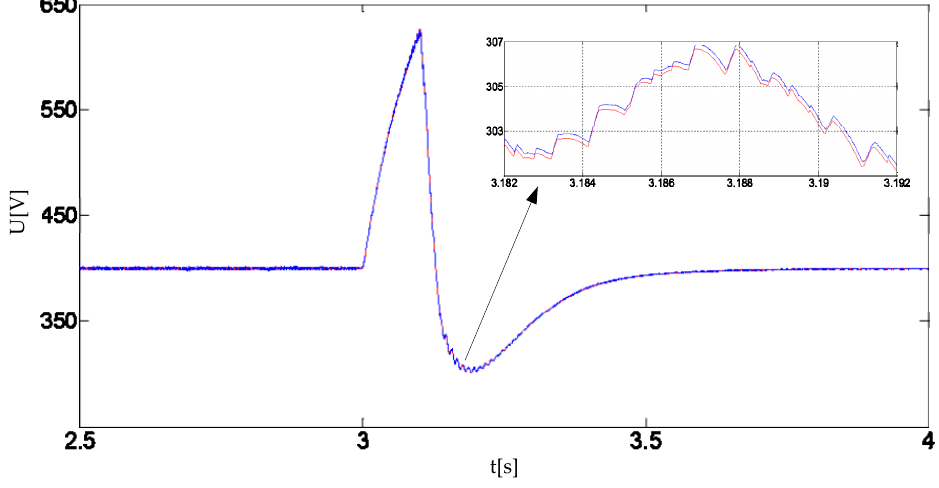
Figure 11. The inverter DC voltage waveform of node 32.